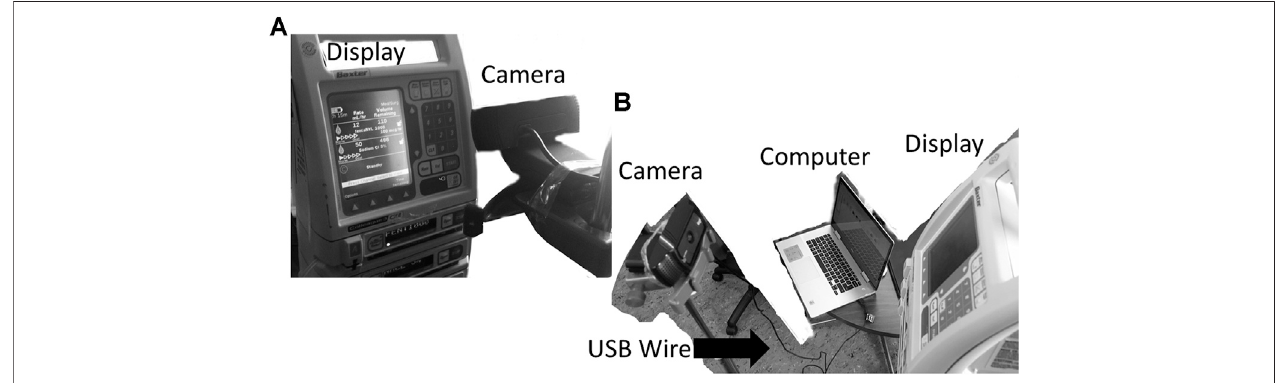
FIGURE 1 | Setup for the camera and pump. General setup for our design, with the monitor display being captured through an external camera is displayed in image (A) and (B) . In fi gure B the USB wire connecting the computer to camera can be seen. The current design has the camera directly in front of the text display.